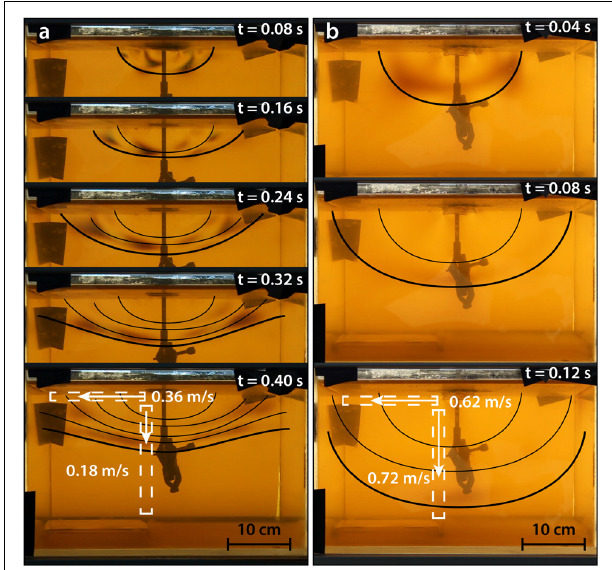
FIGURE 6 | Two sequences of images from experiment Ex3, corresponding to the first and last measurement in Table 1 . We highlight the approximate shape of the wave front with a bold line and previous positions with narrow lines. Velocity measurements were taken within windows defined by the white dashed boxes. All velocity measurements have an error of ∼ 10% of the measured value. (a) After ∼ 1 day of solidifying, the perimeter of the gelatin had hardened more than the middle. The wave propagates about twice as faster along the upper surface than through the center of the block. (b) The wave propagates at similar velocities along the upper surface and through the center. The measurements match within error